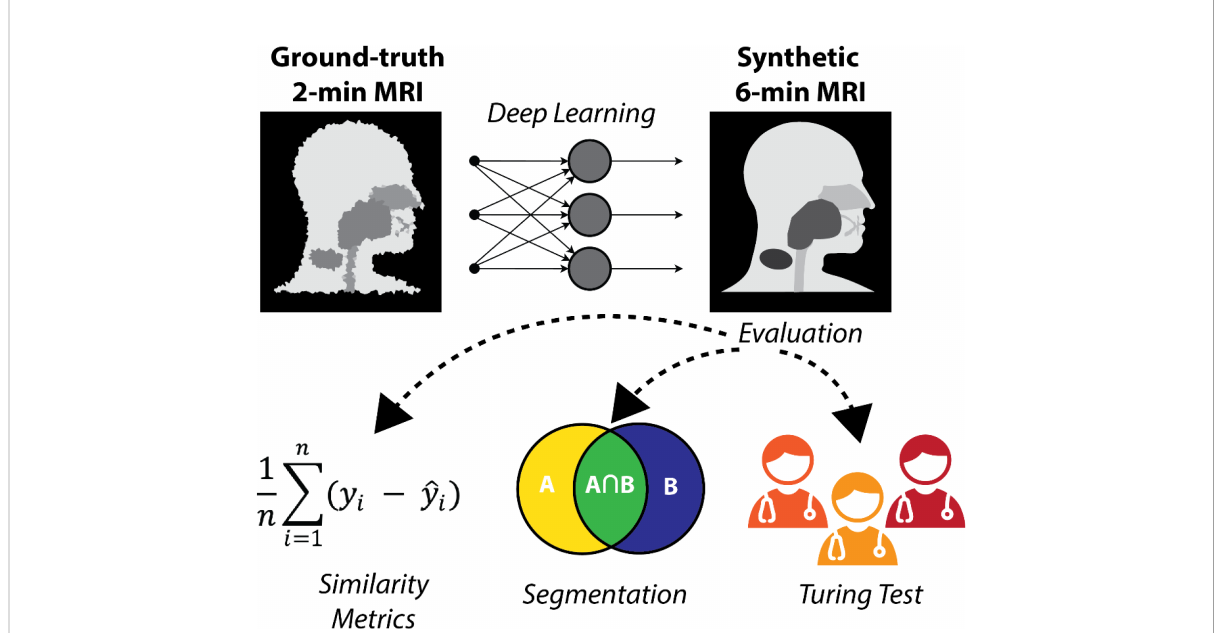
FIGURE 1 Study overview. 2-minute MRI scans are used as input to a deep learning model to generate synthetic 6-minute MRI scans. The synthetic 6-minute scans are compared to ground-truth 6-minute scans through various quantitative and qualitative